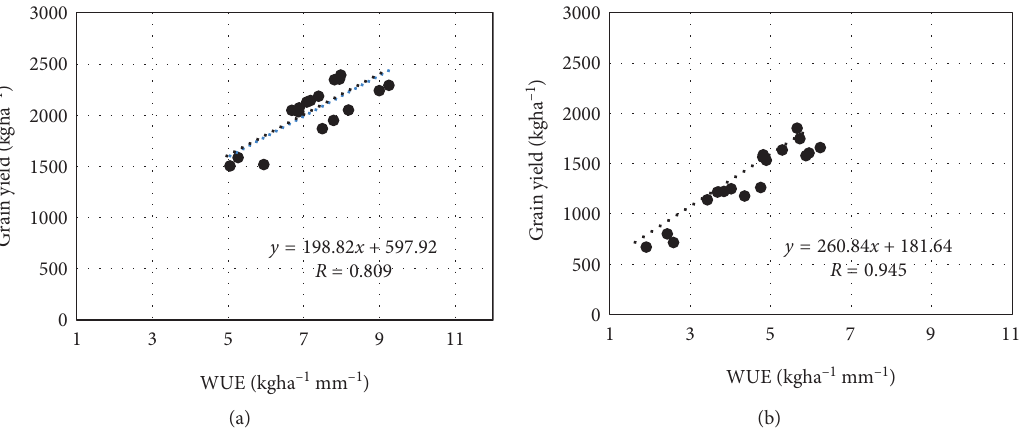
Figure 3: Linear relationship between pearl millet WUE and grain yield (Y) in Minjibir and Gambawa sites. Each data point represents mean grain yield and TWU across N-fertilizer rates over two growing seasons (2014 and 2015). (a) Minjibir and (b)